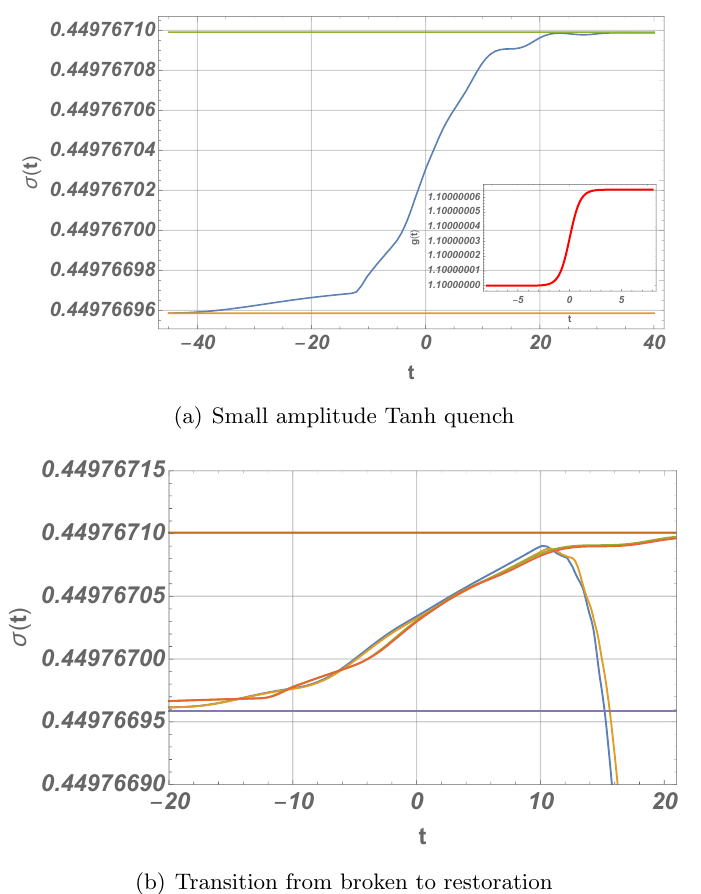
Figure 2 . (a) Plot of (cid:27) ( t ) as a function of time. We have chosen, g i = 1 : 1 ; g f = 1 : 1+10 (cid:0) 7 : 184 ; (cid:14)t = 10 ; (cid:3) = 3, the red inset curve shows g ( t ) vs. t . The orange line corresponds to the equilibrium (cid:27) for g = g i and the green corresponds to (cid:27) for g = g f . In (b) we plot the various (cid:27) pro(cid:12)les for di(cid:11)erent quench